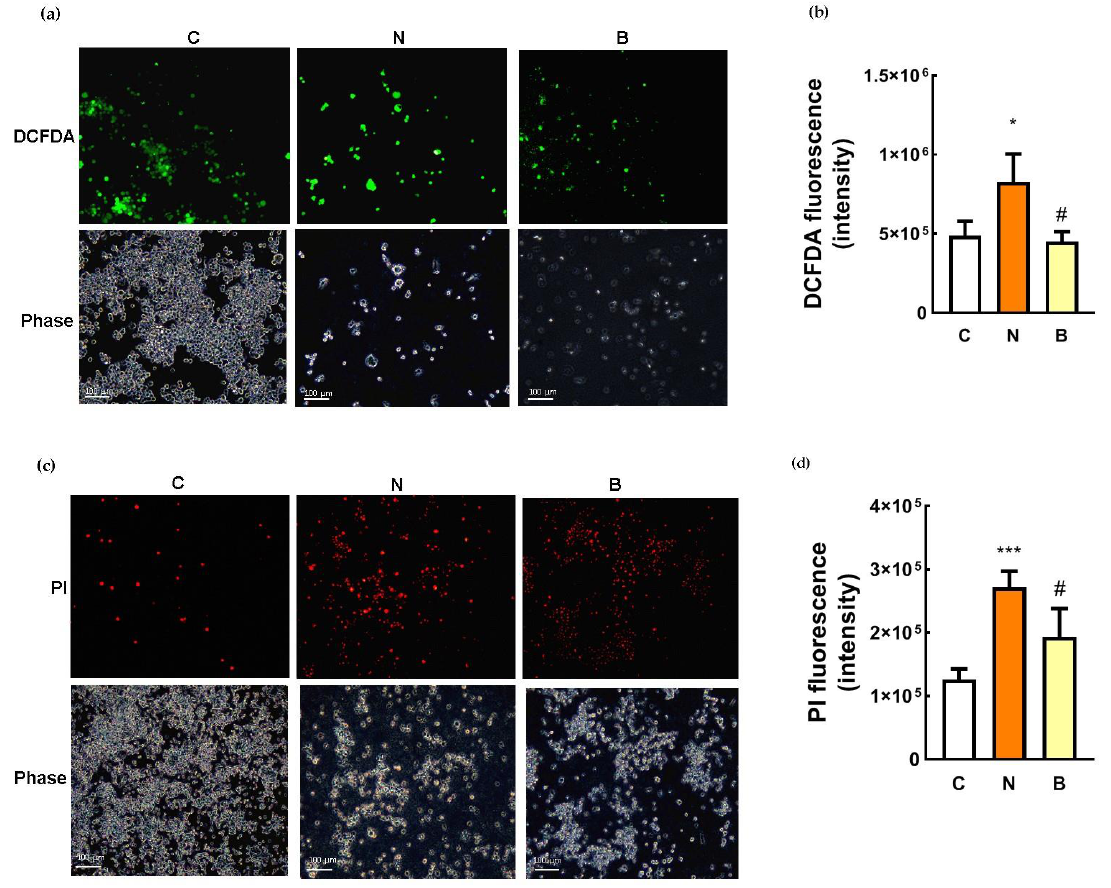
Figure 2. Effect of β -hydroxybutyrate on glucose-deprivation-induced oxidative stress and neuronal cell death. Neuro-2a cells were cultured in the glucose-containing basal condition (C group), or in the condition of glucose deprivation with (B group) or without the presence of 10 mM β - hydroxy- butyrate (N group) for 24 h. After exposure to the different conditions, intracellular ROS generation was determined by DCFDA staining, and neuronal cell death was determined by propidium iodide (PI) staining. ( a ) Representative images of DCFDA staining showing the generation of ROS within Neuro-2a cells, which is visualized in green; phase contrast images are also shown. ( b ) Quantifica- tion of DCFDA fluorescence. ( c ) Representative images of PI staining showing the dead cells which